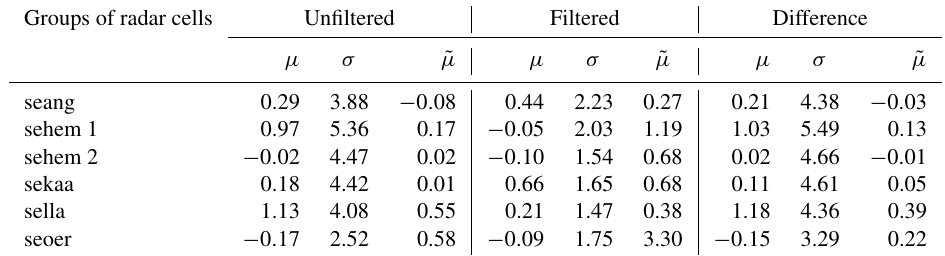
Table 4. Statistical parameters for the difference in pairwise reflectivity values measured using horizontal and vertical polarization for all selected groups of radar cells and three different data sets. Mean values ( µ ) are in dB, standard deviation ( σ ) is in dB, and skewness ( ˜ µ ) is unitless. Groups of radar cells Unfiltered Filtered Difference µ σ ˜ µ µ σ ˜ µ µ σ ˜ µ seang 0.29 3.88 − 0 . 08 sehem